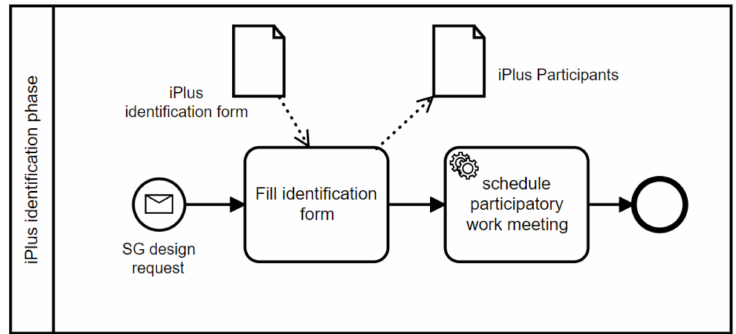
Figure 3. Process Description—Identification